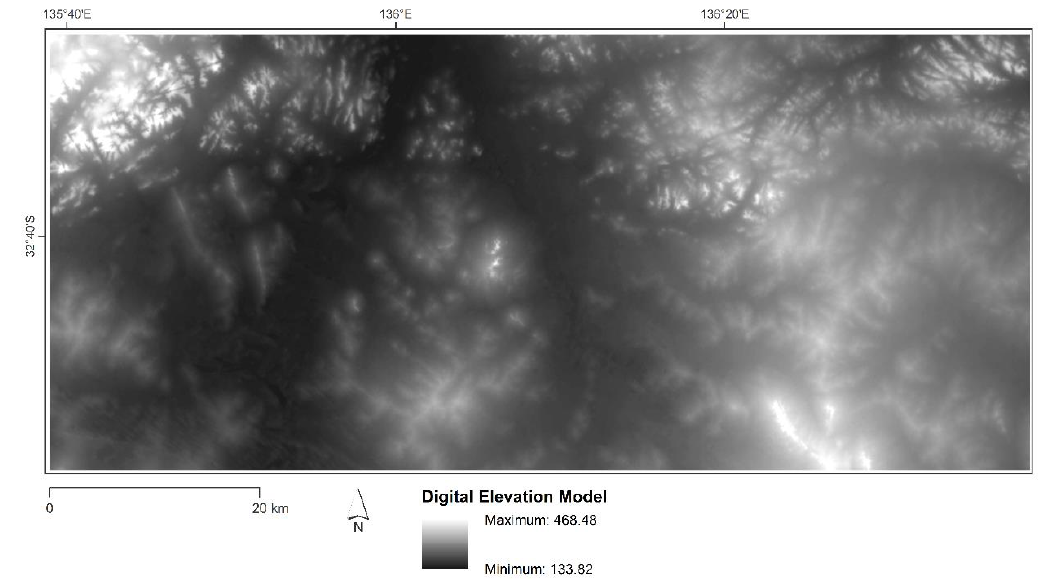
Figure 5. 1-s Digital Elevation Model (DEM) used as an input for the unsupervised classification, sourced from Geoscience Australia.